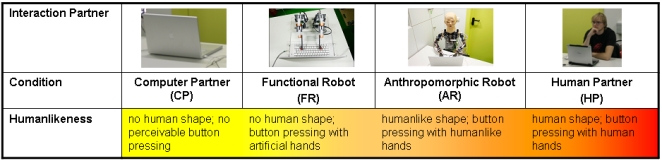
Surmised game partners (abbreviations) with increasing degrees in human-likeness.